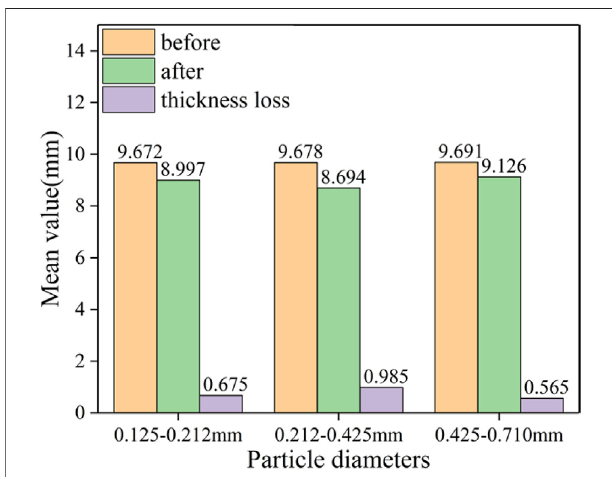
FIGURE9| Meanvalueofbladethicknessatthemeasuringpointrelated with different particle diameters.